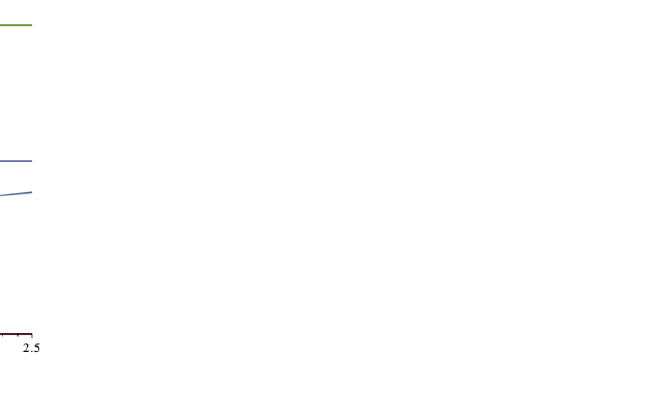
Figure 7. k as a function of ρ .